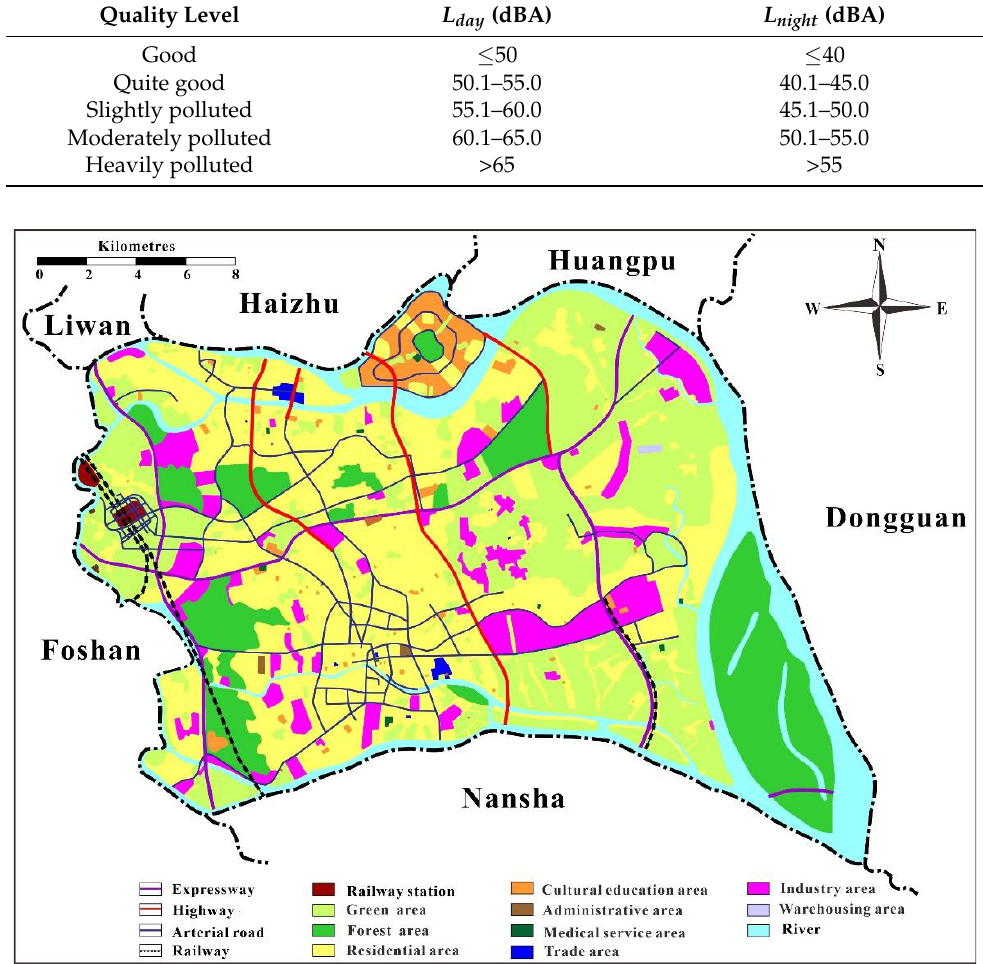
Figure A5. Distribution of functional areas and traffic arteries in Panyu District of Guangzhou City [36].